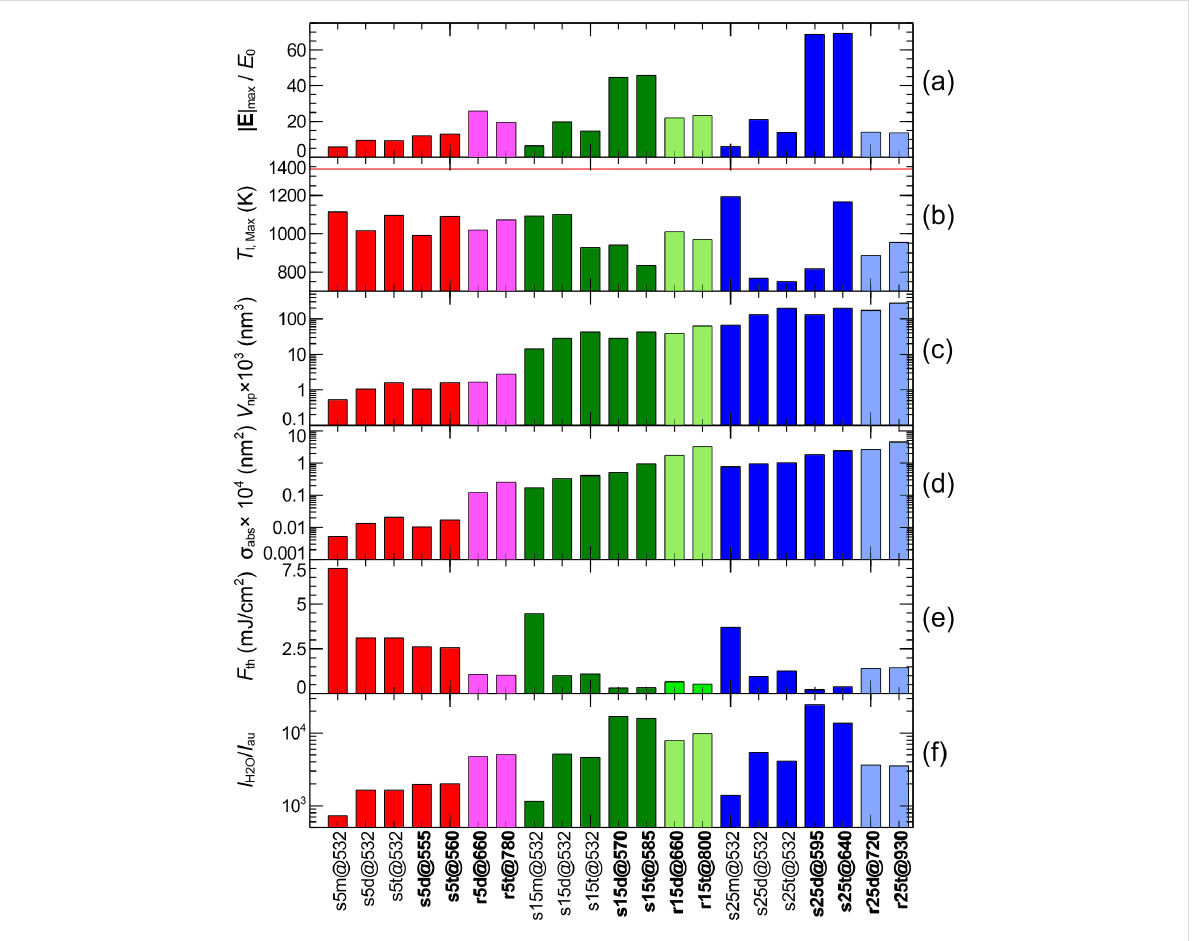
Figure 5: Nanoparticles of different morphology used in the model and corresponding parameters obtained to reach optical breakdown. The first letter of the label (e.g., s5m@532), “s” or “r”, stands for nanosphere and nanorod, respectively. The numbers 5, 15 and 25, correspond to radius of the nanoparticle in nanometers. “m”, “d”, “t” stands for monomer, dimer and trimer, respectively. The last number of the label corresponds to the wave- length, λ (nm), used in the simulations. Bar plot (a), | E | max / E 0 , provides the data of the maximum electric field enhancement that is located in the hot zone of the nanoparticle (see Figure 4a–d). Bar plot (b) shows the maximum lattice temperature, T l,max , reached at the end of the laser pulse duration, measured in the hot zone of the particle (Figure 4e–h) (the red line marks the melting temperature of gold at 1337 K [38]). Bar plot (c) compares the volumes of the nanoparticles, V np . Bar plot (d) shows the absorption cross-section, σ abs , of the nanoparticles and their assemblies. Bar plot (e) compares the laser fluence, F th , needed to reach the critical density of the free electrons for bubble formation, ρ cr = 10 20 cm − 3 [22,34], in the vicinity of nanoparticle. Bar plot (f) provides the ratio of optical breakdown threshold intensity for pure water for 3 ps pulses at 580 nm, I H2O = 8.5 × 10 11 (W/cm 2 ) [56] and an aqueous environment containing gold nanoparticles, I au (this